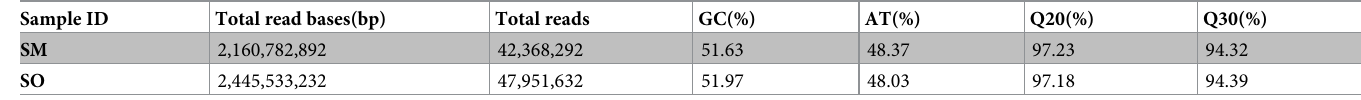
Table 1. The total number of bases, reads, GC (%), Q20 (%), and Q30 (%) are calculated for the 2 assayed almond cultivars. Sample ID